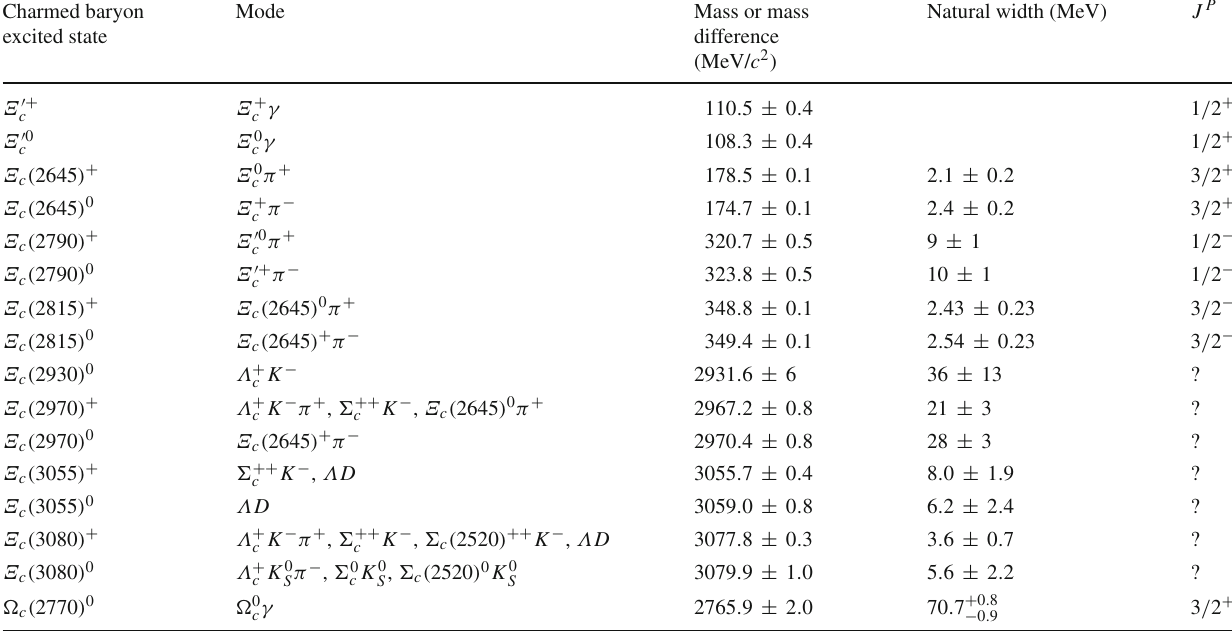
Table 299 Summary of excited Ξ + , 0 c and (cid:21) 0 c baryon families. For